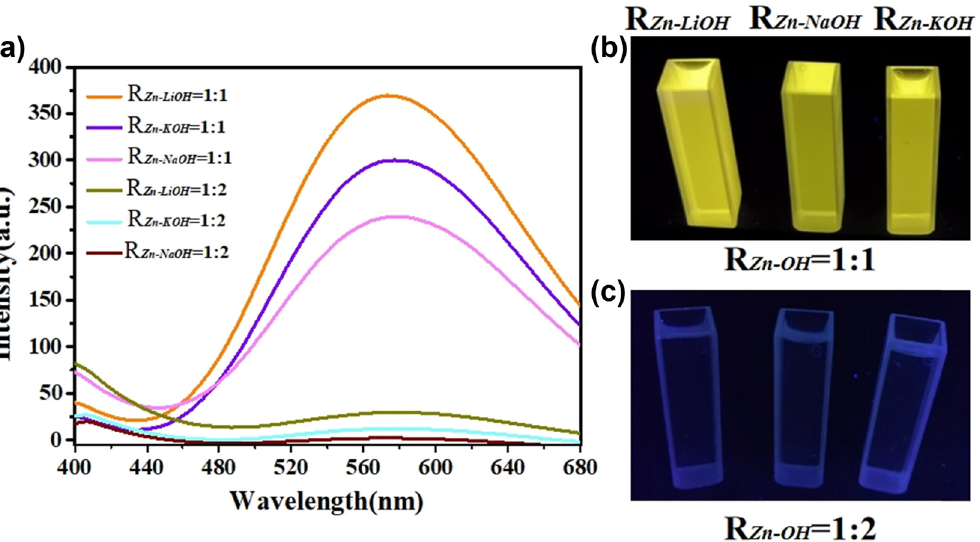
Figure 10: Liquid - state fl uorescence spectra of ZnO QDs synthesized under di ff erent alkali bases and di ff erent R Zn − OH values ( a ) . Images of the ZnO QDs under UV lighting and white lighting conditions ( b and c )